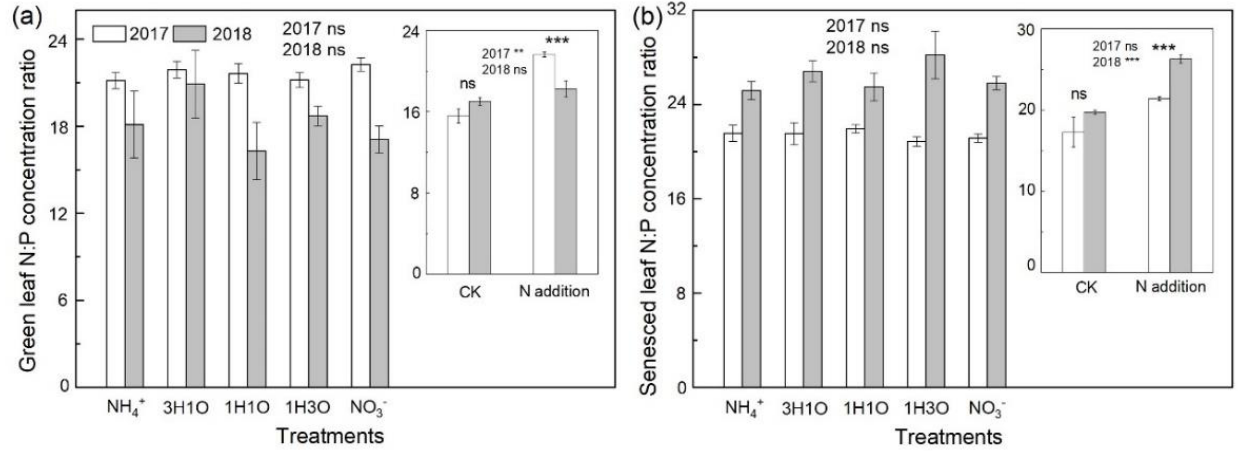
Figure 4. Response of ratios of N:P in green ( a ) and senesced leaf ( b ) to various N form fertilizations. The asterisks and ns above the white and gray bar graphs represent the significance between 2017 and 2018. The asterisks and ns following the number of years inside the little figure represent the significance in control ( n = 4) and N addition (average, n = 20). The asterisks and ns following the number of years outside the figure represent the significance in N addition groups. * p < 0.05; ** p < 0.01; *** p < 0.001; ns, not significant.